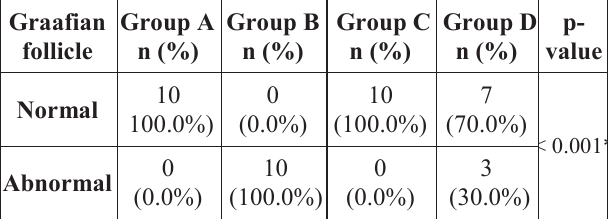
Table-4: Distribution of appearance of Graafian follicle among control & experimental groups based on Fisher’s exact test